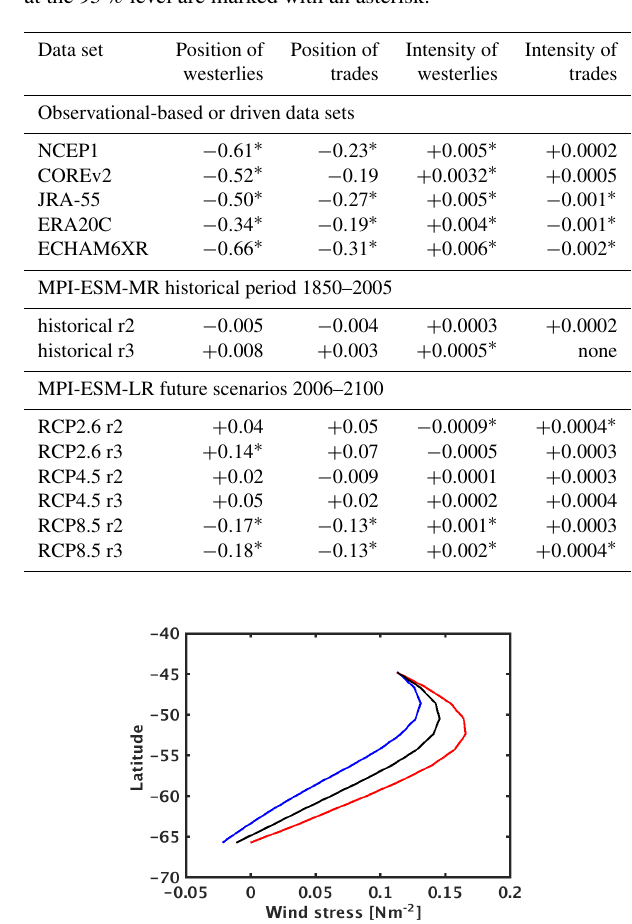
Table 1. Trends of the position (degrees per decade) and in- tensity (Nm − 2 per decade) of the westerlies and trades for the five observational-based data sets (NCEP1, COREv2, JRA-55, ERA20C, ECHAM6XR), for two free-running MPI-ESM simula- tions (r2 and r3) for the historical period, and for two simulations (r2 and r3) for three future scenarios. Statistically significant trends at the 95% level are marked with an asterisk.